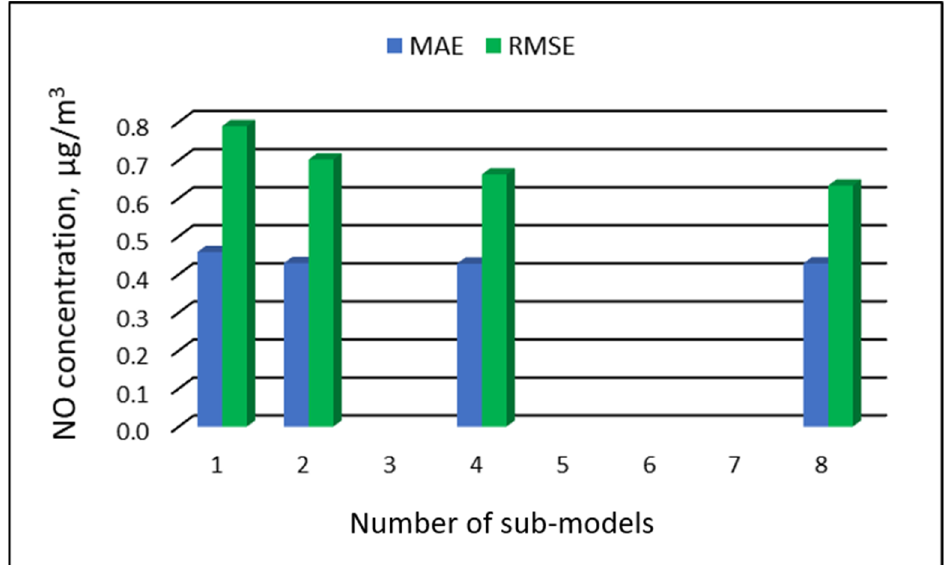
Figure 10. Overall MAE and RMSE values for NO concentration prediction in PVS models depending on the number of created sub-models, Z ł oty Potok.